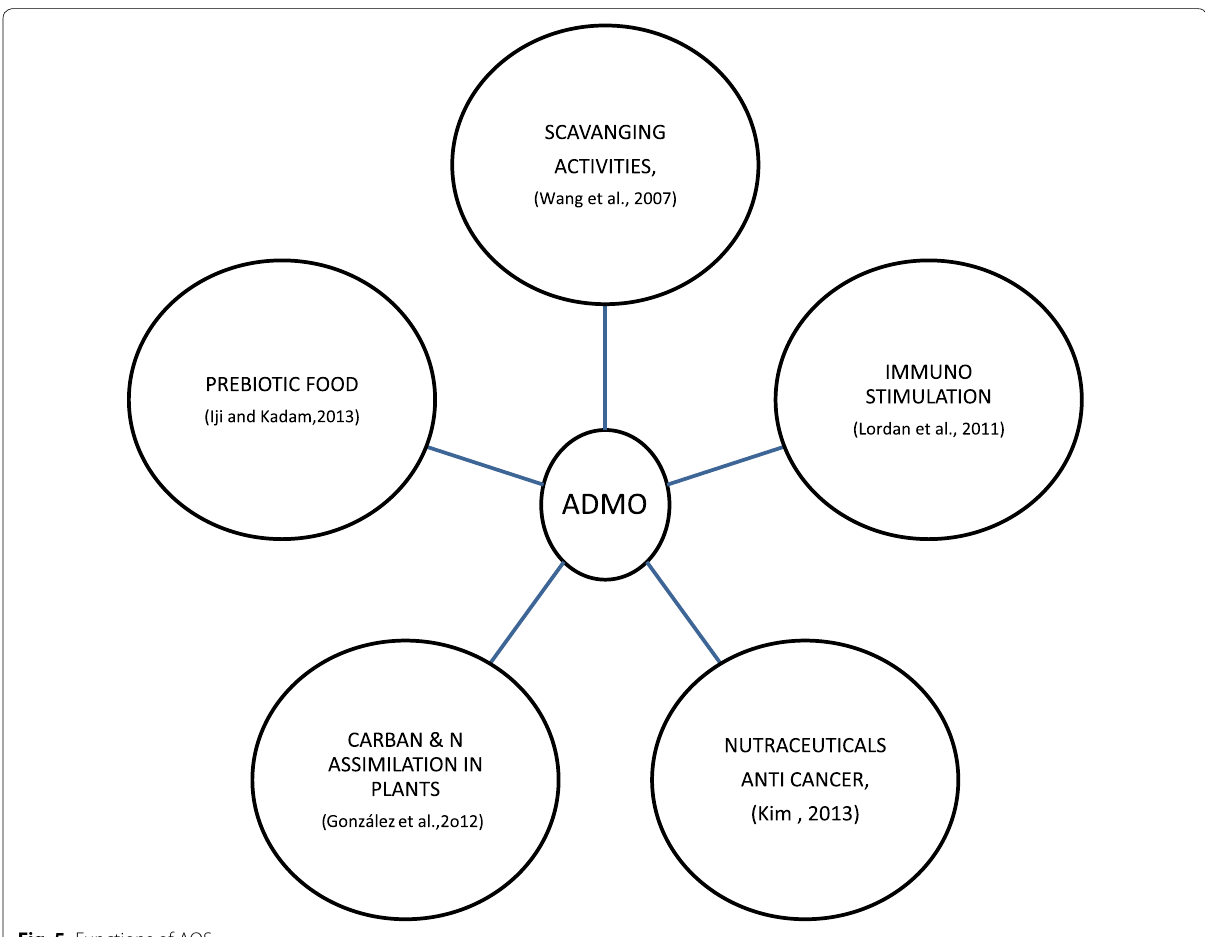
Fig. 5 Functions of